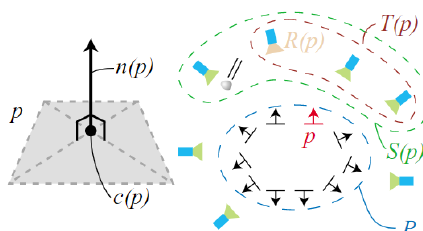
Figure 2 . A patch and its associated images (Furukawa,